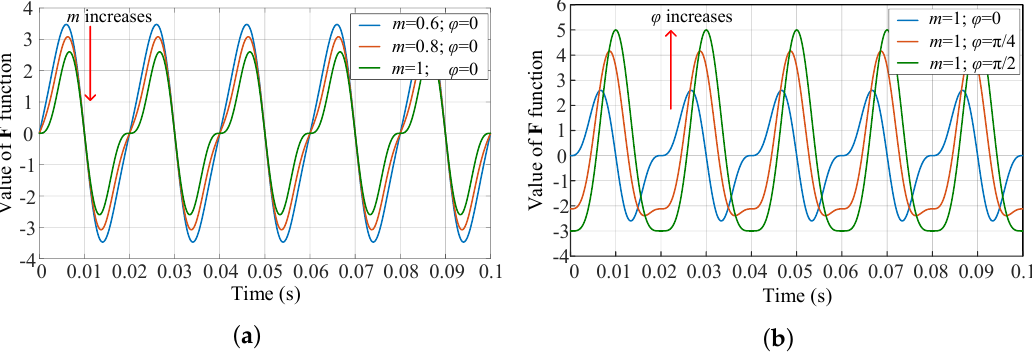
Figure 3. Waveforms of the F function with ( a ) φ = 0, m = 0.6, 0.8, 1 and ( b ) m = 1, φ = 0, π /4, π